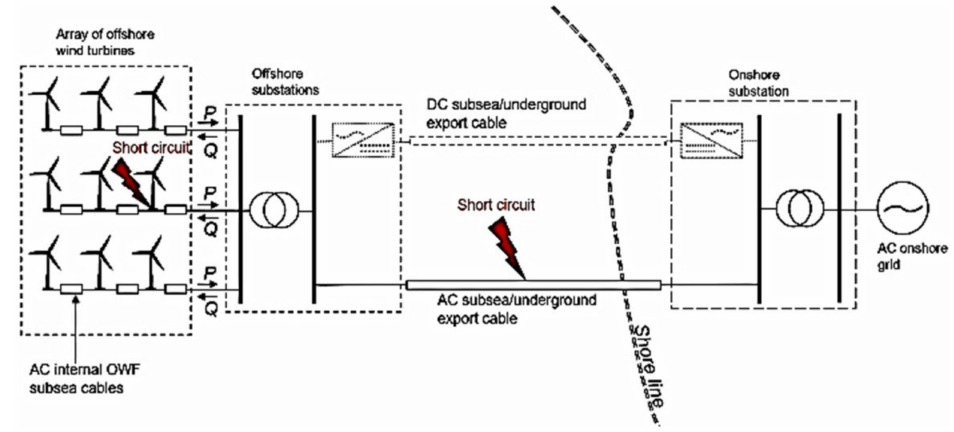
Figure 3. Potential fault locations on offshore wind farms [21].